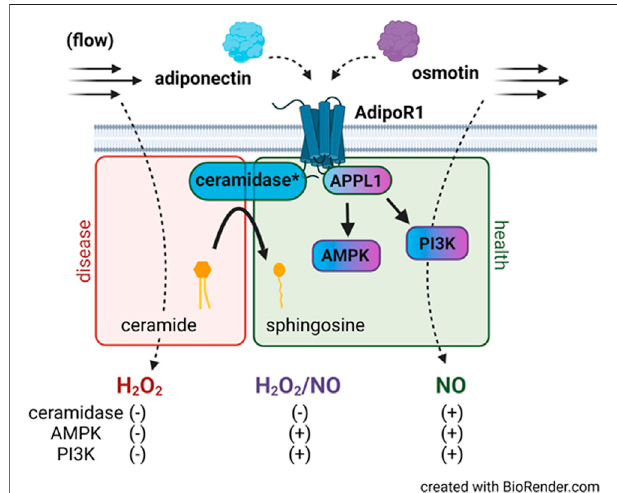
FIGURE 5 | AdipoR1 signaling in the microvascular endothelium. Activation of AdipoR1 by adiponectin (blue) can activate multiple downstream pathways including AMPK and PI3K via the adapter protein APPL1. Adiponectin receptors have intrinsic ceramidase activity that allows for hydrolysisofceramidetosphingosine.ExogenousadiponectinpromotesNO- mediated FID in vessels from patients with CAD while accumulation of ceramide in healthy vesselspromotes formation ofH 2 O 2 during fl ow. Osmotin (purple)likeadiponectinactivatesAdipoR1,APPL1,AMPK,andPI3Khowever dilation to both NO and H 2 O 2 is observed in arterioles from subjects with disease. Whether osmotin is capable of triggering the ceramidase activity in AdipoR1 remains unknown. *ceramidase activity is within the adiponectin